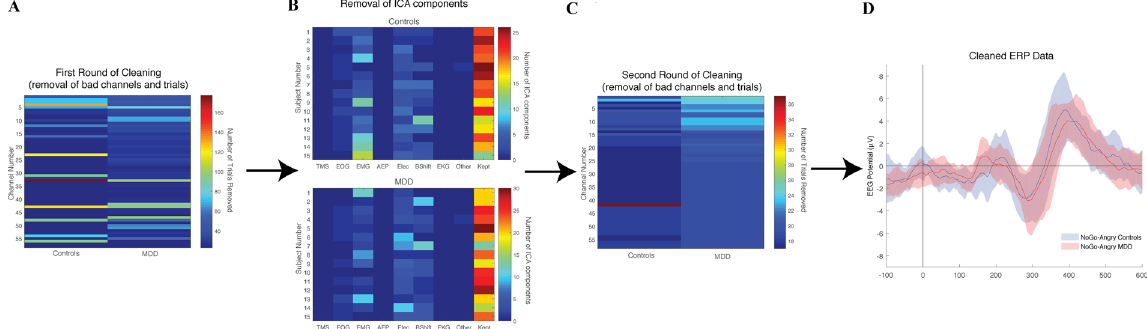
Figure 4. Illustration of Utility of the ERPEEG Toolbox with Pilot Data. The panels illustrate application of ERPEEG toolbox on pilot data from CAN-BIND project 1. Pilot data include EEG collected during affective Go/noGo task in 15 healthy controls and 15 MDD patients. Raw data were imported into MATLAB via EEGLAB 9 , epoched around onset of each stimulus (e.g., Go or NoGo cue superimposed on angry, happy or neutral faces), and preprocessed with ERPEEG toolbox. Panels A to C illustrate the outcomes of steps 2, 5, and 6 of ERPEEG toolbox, respectively, compared visually between MDD and control groups. Panel D, illustrates the final cleaned ERP, outcome of step 7, compared between MDD and controls for NoGo angry face condition. ( A , C ) In both panels, x-axes depict two groups of controls and MDD, and y-axes depict channel number, while colors illustrate number of trials removed for each channel averaged across subjects following step 2 (panel A), and step 6 (panel C). ( B ) In both panels, the x-axis depicts the component type (e.g., component related to eye blinks, bad electrodes, EKG, etc), y-axis shows the subject number, and the colors depict number of components removed in control (top) and MDD (bottom). The matrix of deleted trials depicted in each of these images can be used to systematically compare the data processing across controls and patients, but also across different investigators, and